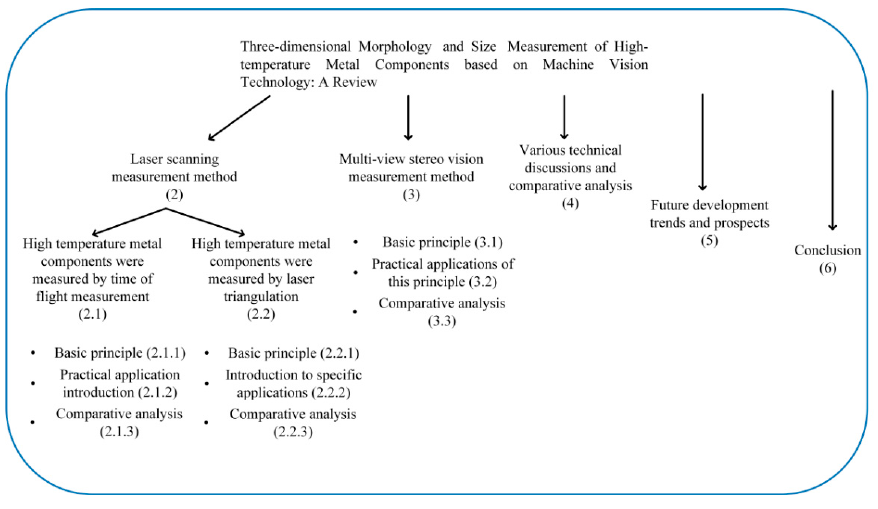
Figure 2. The frame structure of the article.